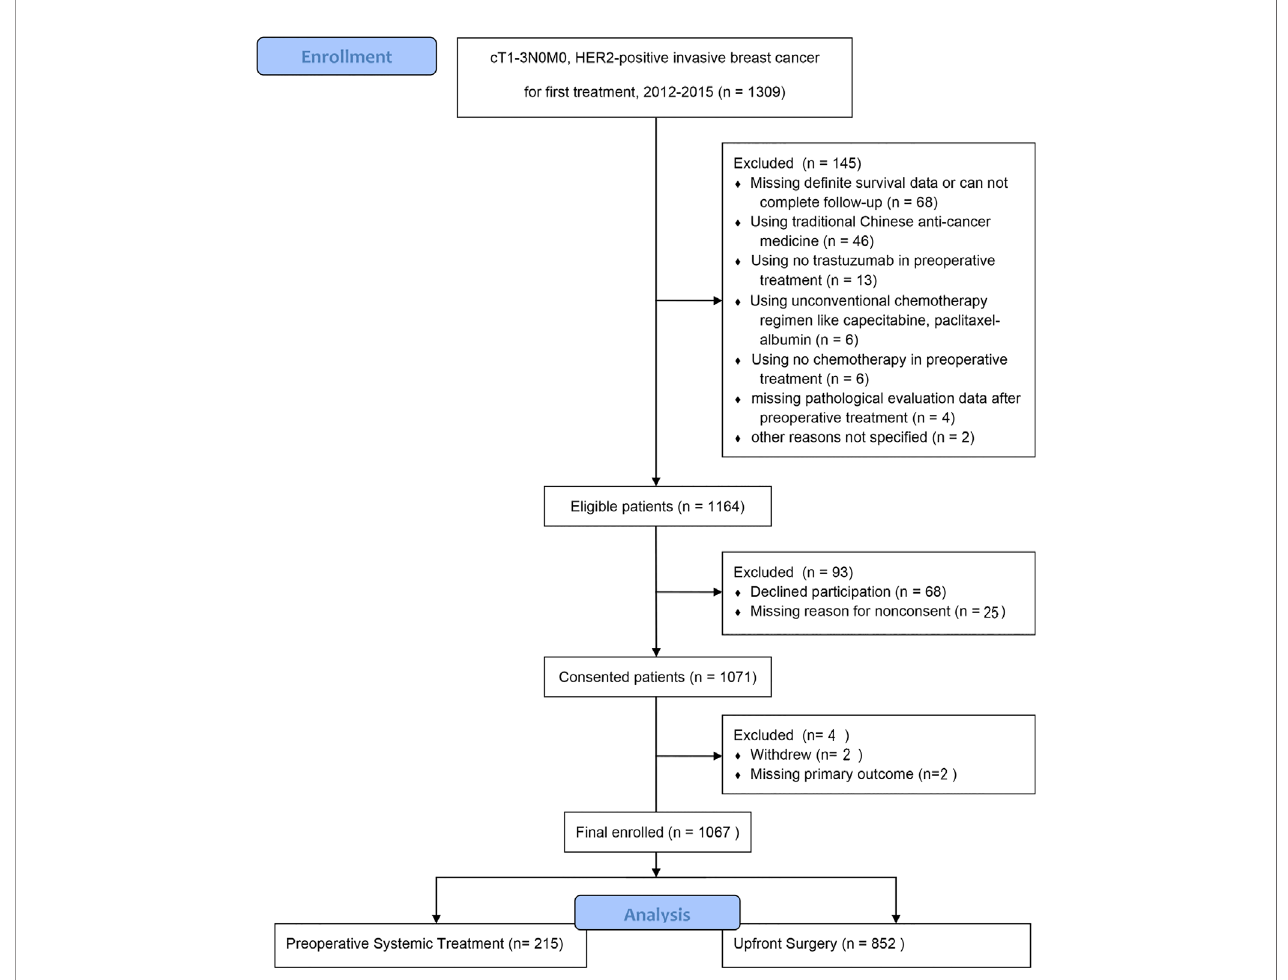
FIGURE 1 | Flow diagram of participants with operable HER2-positive breast